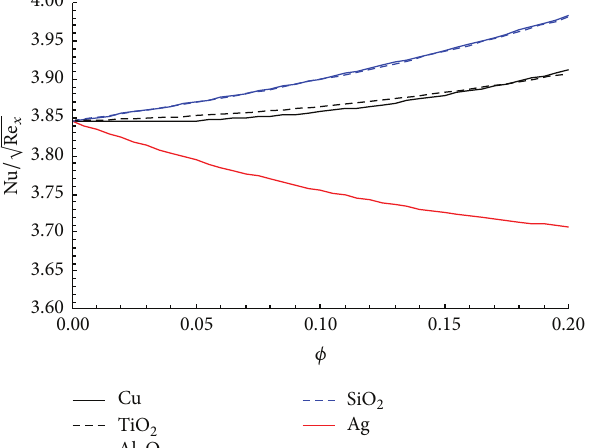
Figure 13: Comparing the variation of reduced Nusselt number as a function of 0 ≤ 𝜙 ≤ 0.2 for the investigated nanoparticles 𝑃𝑟 = 6.2 , = 0.5 , 𝛿 = 0 , and 𝑠 = 0.5 𝛿 1 2